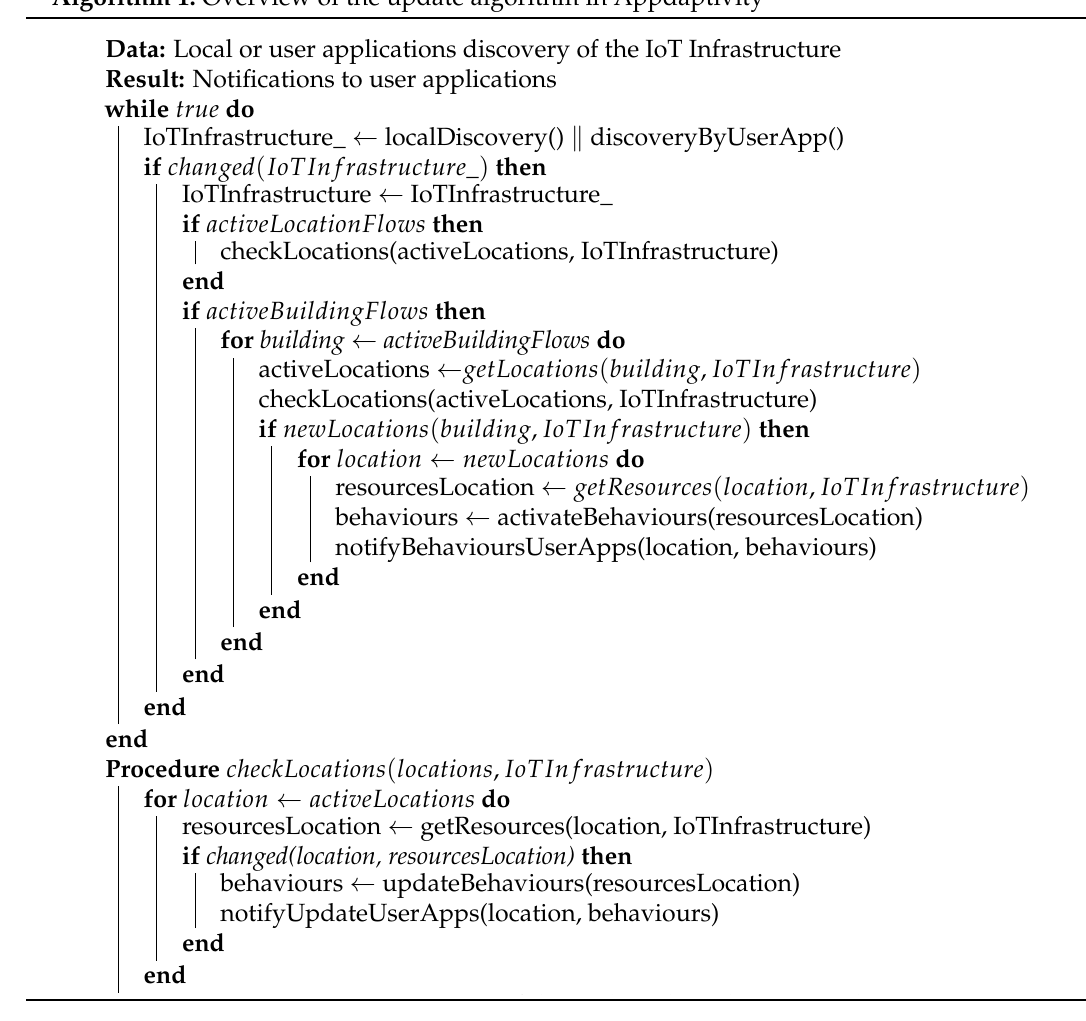
Algorithm 1: Overview of the update algorithm in Appdaptivity